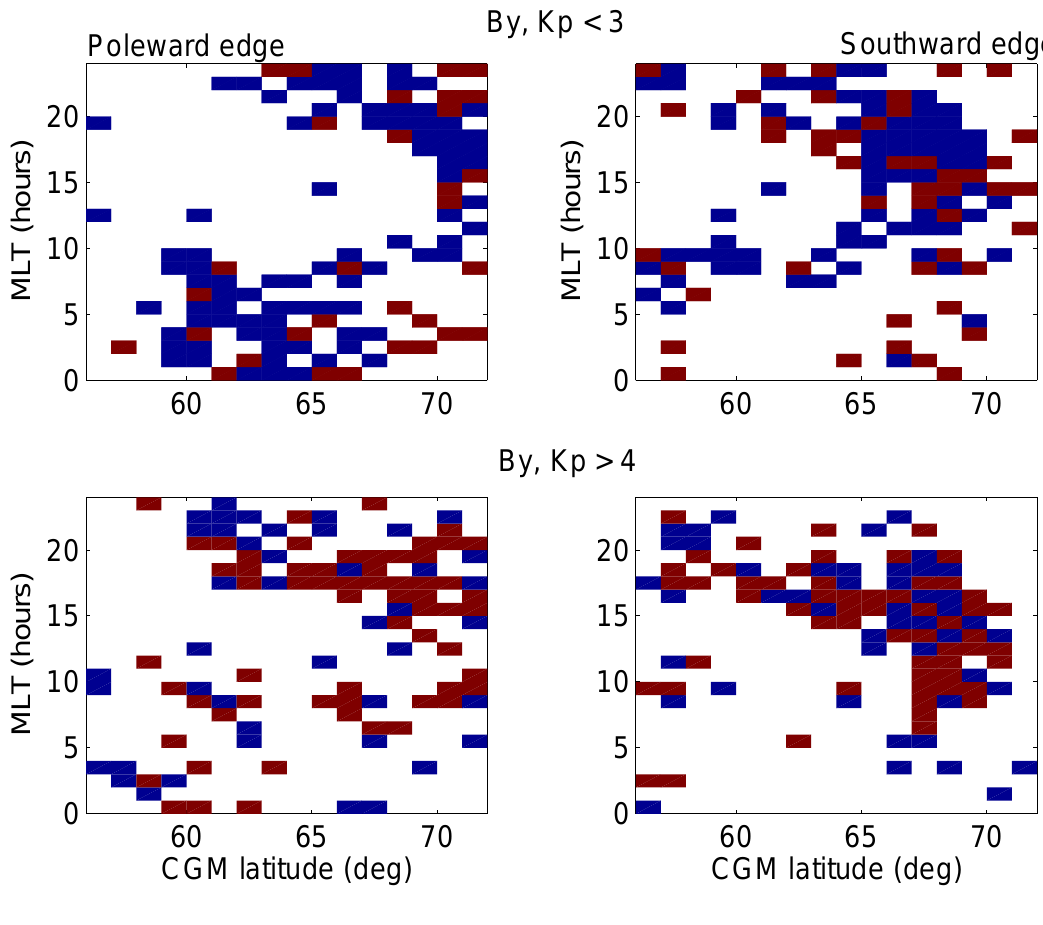
Fig. 9. Same as Fig. 8 for By. equatorward edge lies at the equatorward border of the con- vection pattern. The dayside trough forms in the vicinity of the return flow of the dusk convection cell (Pryse et al., 1998) in regions where the sunward convective transport displaces the high density plasma with the low density plasma from the night side (Whalen, 1989). The nightside trough is created within the stagnation region which appears where the west- ward convection and eastward corotation more or less cancel each other. Besides the decay of the plasma concentration, low density plasma is transported by the westward convec- tion from later night local times. The size and structure of the convection pattern is controlled by the IMF. When Bz is positive, the extent of the convection pattern is limited by the small polar cap. When Bz is negative, the polar cap and the convection pattern extends to lower latitudes. The latitudes of particle precipitation are largely but not absolutely con- nected with the convection pattern. If Bz is positive and Kp is low, precipitation region may lie to the north of the narrow